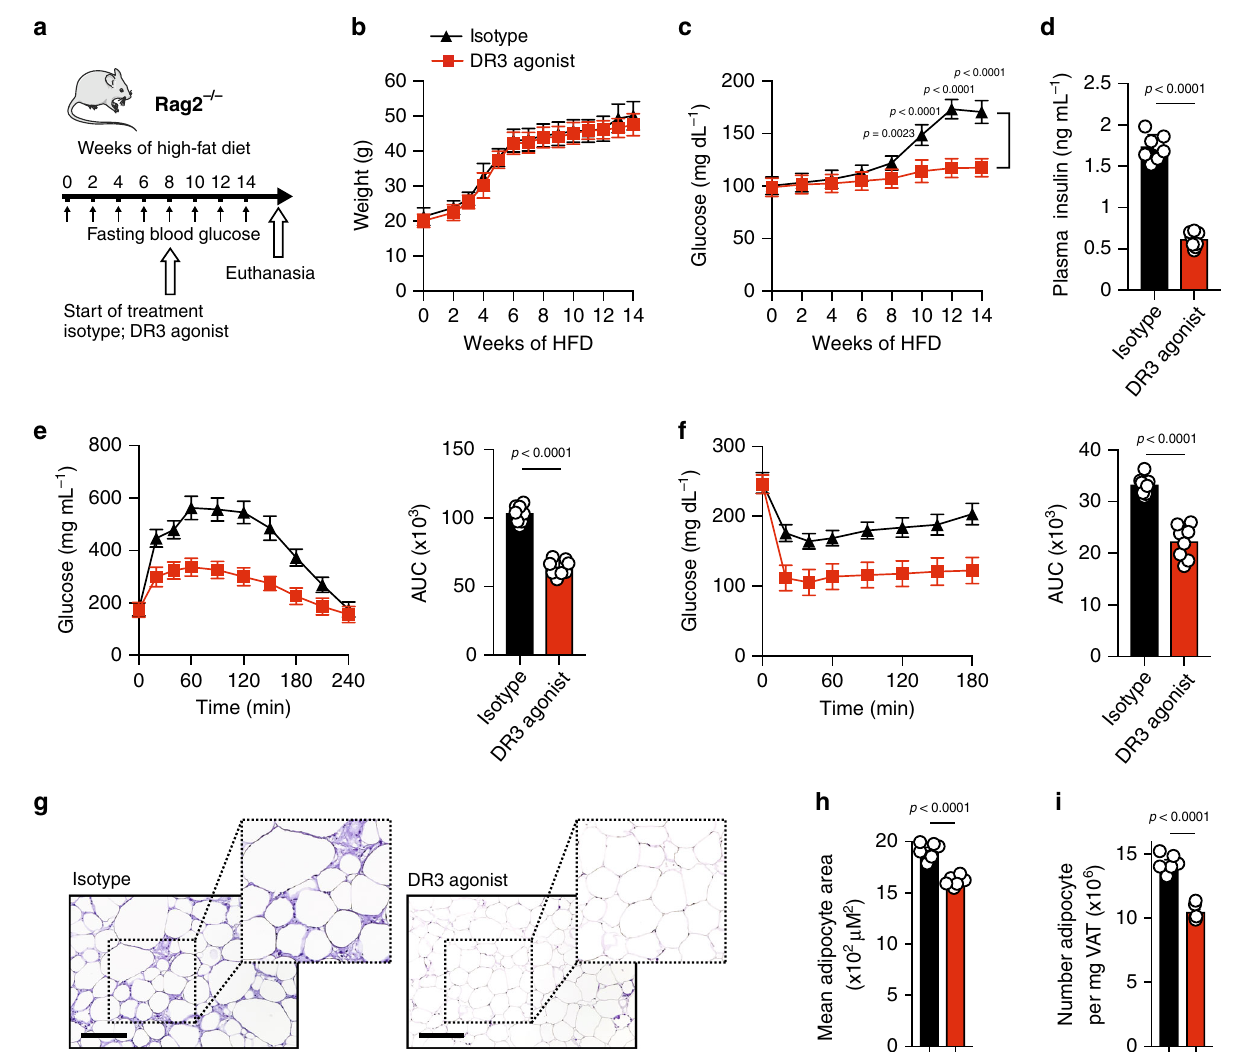
Fig. 4 Therapeutic DR3 treatment ameliorates established type 2 diabetes in Rag2 − / − mice. a A cohort of Rag2 − / − mice were placed on HFD for 14 weeks. After 8 weeks of diet, mice were subjected to intraperitoneal treatments with either DR3 agonist (1 mg/mouse) or isotype control once every four days as indicated in the timeline, n = 8 mice. b Total weights were measured once a week, and c the fasting blood glucose levels were measured once every 2 weeks for a period of 14 weeks. d Plasma insulin concentrations were determined using ELISA. e Glucose tolerance test and f insulin tolerance test were performed at the end of the treatments. g Hematoxylin and eosin-stained epididymal adipose tissue sections (×400, scale bars, 100 μ m). The mean adipocyte area ( h ) and numbers ( i ) in VAT were quanti fi ed at the end of 14 weeks. The area under the curve (AUC) was calculated for each cohort. Error bars are representative of the mean ± SD. Statistical analysis, one-way ANOVA ( b , c ), two-way ANOVA ( e , f ), two-tailed student ’ s t -test ( d , h , i ). Mouse image provided with permission from Servier Medical